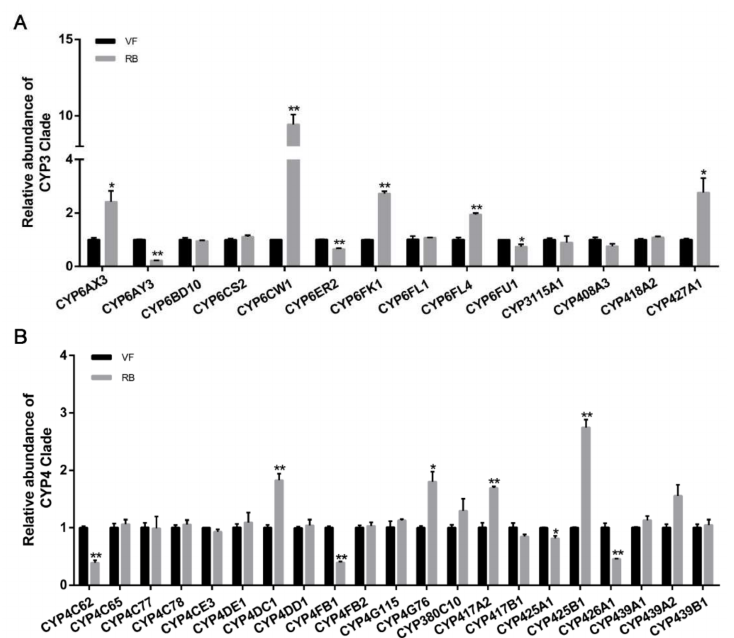
Figure 3. The expression of thirty-five P450s in CYP3 clade and CYP4 in L. striatellus under RBSDV infection. ( A ) Analysis of expression of P450s in CYP3 clade by RT-qPCR. The 3rd-instar nymphs of RBSDV-free L. striatellus were reared on RBSDV-infected plants and transferred to healthy rice seedlings until 5th-instar nymphs. The L. striatellus was collected as RBSDV-infected L. striatellus , and the nymphs reared on the healthy rice seedlings were collected as control. ( B ) Analysis of the expression of P450s in CYP4 clade by RT-qPCR. The asterisk (*) and asterisks (**) indicate p < 0.05 and p < 0.01.